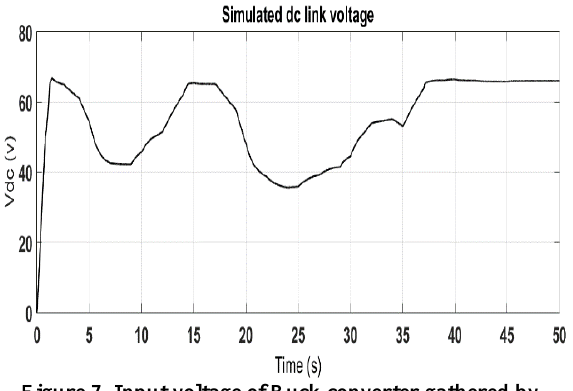
Figure 5. Proposed method flowchart.